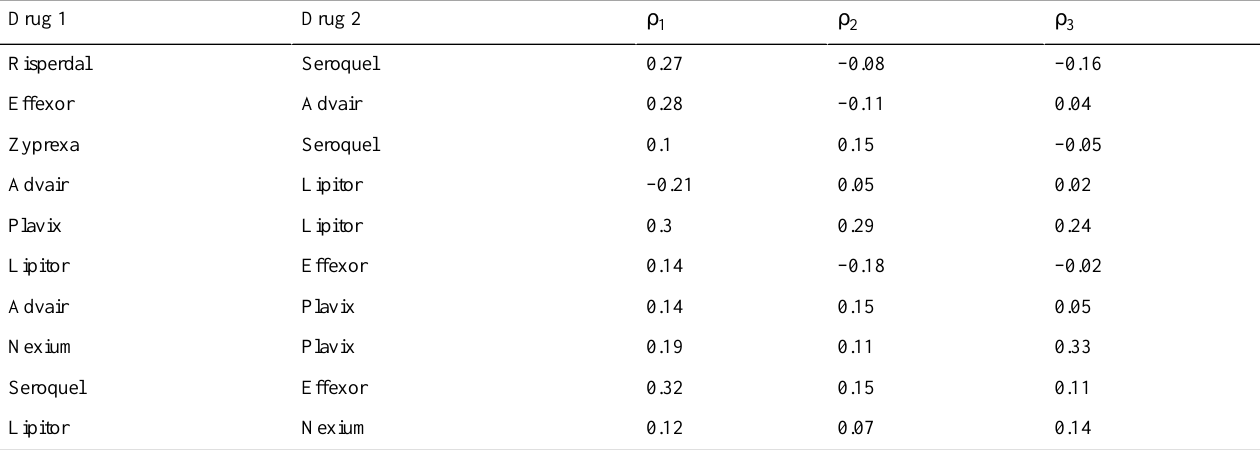
Table 6. Spearman rank correlation ( ρ ) between the adverse drug reactions (ADRs) of pairs of drugs identified by query log reaction score (QLRS) and by the number of reports in the Adverse Event Reporting System (AERS), with most discordant ADRs (MDADRs) removed according to the raw report counts in